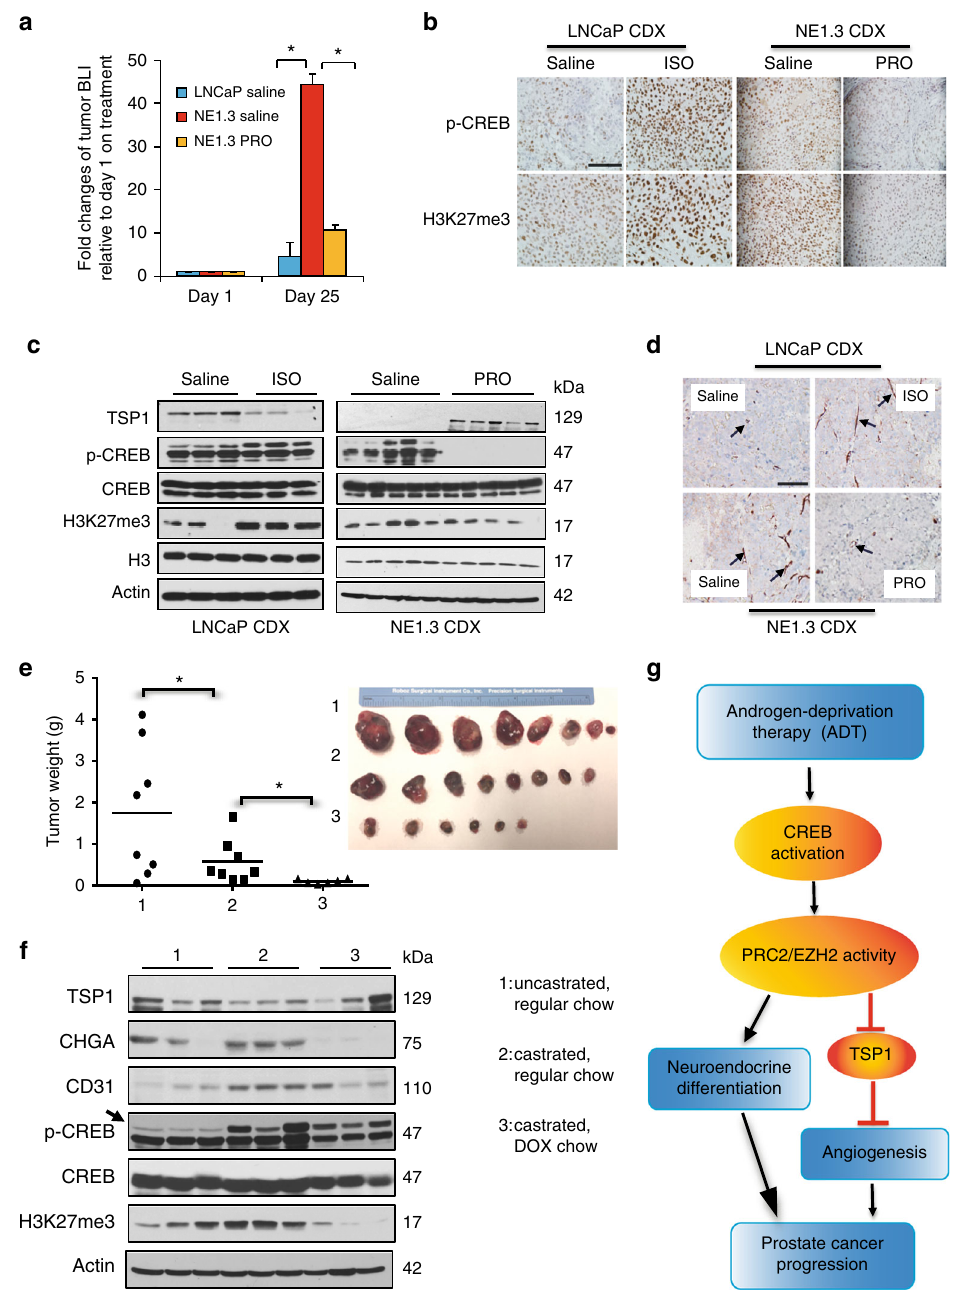
Fig. 10 CREB repression inhibits growth of NEPC xenografts, and blocks castration-activated EZH2 axis and angiogenesis in vivo. a NOD/SCID mice were injected with luciferase-labelled LNCaP or NE1.3 cells, which were then treated daily with saline or 2 mg kg − 1 propranolol for 25 days, as indicated (6 mice in each group, 2 tumors in each mouse, n = 12). The tumor growth was monitored by bioluminescent imaging (BLI) with IVIS instrument. Presented on Y - axis are average fold changes of BLI signals for each tumor at day 25, relative to BLI signals at day 1 of treatments. b Left 4 panels: representative images of IHC staining for pCREB-S133 and H3K27me3 in LNCaP-derived xenografts treated daily for 25 days with saline or 10 mg kg − 1 of ISO (tumors from our previous study 36 ). Right 4 panels: representative images of IHC staining for pCREB-S133 and H3K27me3 in NE1.3-derived xenografts treated daily with saline or 2 mg kg − 1 of PRO. c Western blots of xenograft tumors from LNCaP with or without ISO treatments (left) or from NE1.3 with or without PRO treatment (right) for the CREB/EZH2/TSP1 pathway proteins as indicated. d Top two panels: representative IHC staining images of angiogenesis marker CD31 in LNCaP CDX treated with saline or ISO. Bottom 2 panels: representative IHC staining images of CD31 in NE1.3 CDX treated with saline or PRO. The arrows indicated typical CD31 + microvessels. e Left panel: dot plots of tumor weights in the three indicated experimental groups that are collected at the end of the experiment. Right panel: photographic picture of LNCaP xenograft tumors in the three groups at sacri fi ce. f Western blotting of the proteins on the CREB/EZH2/TSP1/NE pathway in the indicated three groups of LNCaP xenograft tumors. g A summary model of the key fi ndings in this study. ADT activates CREB, in part through PKA, which in turn enhances the PRC2 activity of EZH2. EZH2 is critical for ADT/CREB-induced neuroendocrine differentiation and angiogenesis of prostate cancer cells. EZH2 enhances angiogenesis through epigenetically repressing anti-angiogenic factor TSP1. Additional data related to this Figure are in Supplementary Fig. 5. Statistical signi fi cance was determined by using unpaired two-sided Student ’ s t test and shown as mean with s.d. * P < 0.05. Scale bar = 100 µ